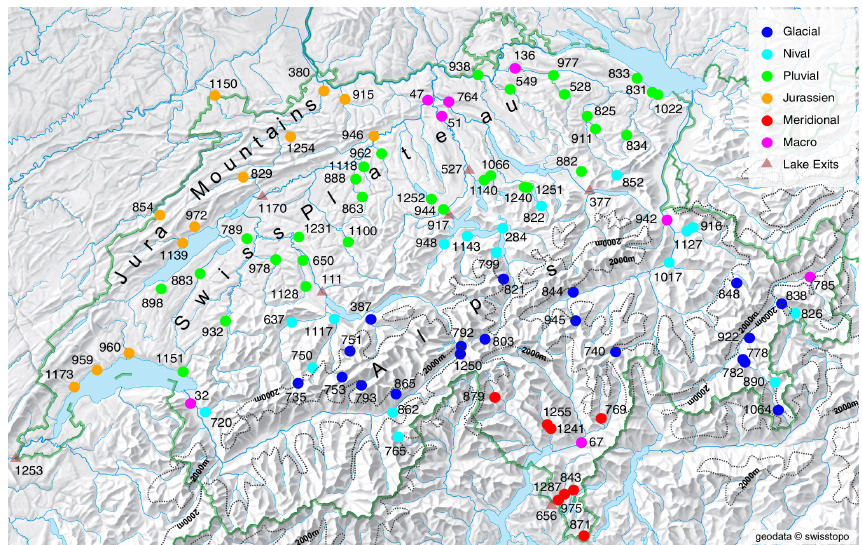
Figure 1. Swiss river discharge stations selected for this study. Colors refer to the hydrological regimes in the legend. Stations at lake outlets are shown by triangles to highlight the strong anthropogenic influence on the discharge (lake outlets are thus analyzed separately). The numbers refer to Table 3 which provide brief descriptions of the